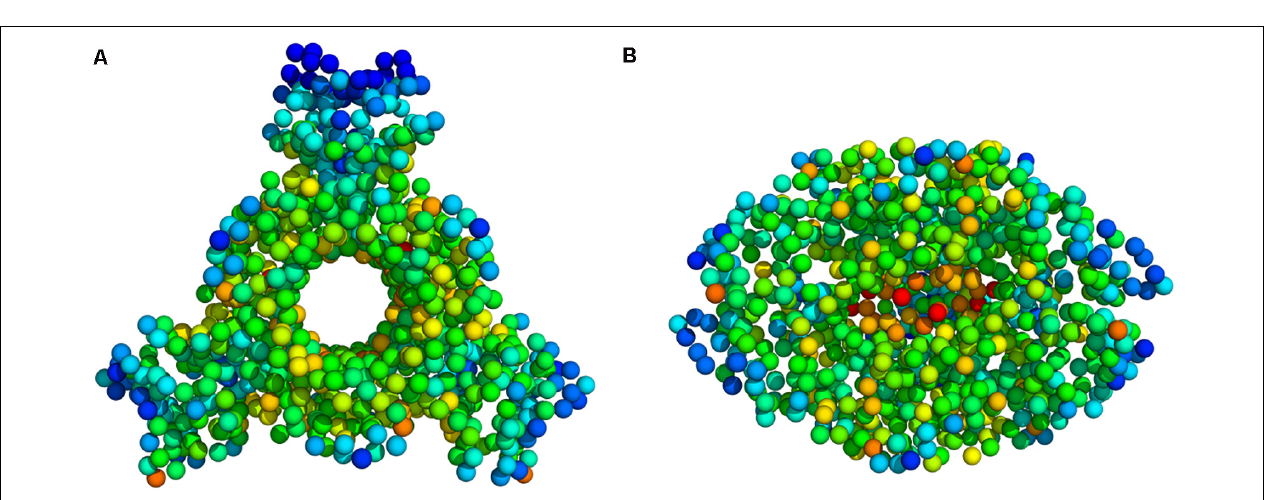
FIGURE 4 | (A) The experimental B-factors mapped onto the PTPS 3D structure. (B) Atomic mobility over the slowest 20 modes. Regions of the lowest fluctuation are shown in blue, higher mobility in green, yellow, and red. The fluctuations color scale is from blue to red (High/ flexible to low/rigid) atomic fluctuation. The figure demonstrates the high mobility of the terminal regions, central helices, and rigidity of the protein core, indicating that the NMA predicted motions have captured most of the experimentally determined motions. (C) Experimental B-factor plot and (D) Lowest 20 modes MSF profile. The residues index is labeled for one chain along the lower abscissa and according to the P. falciparum (PDB ID: 1Y13) file.